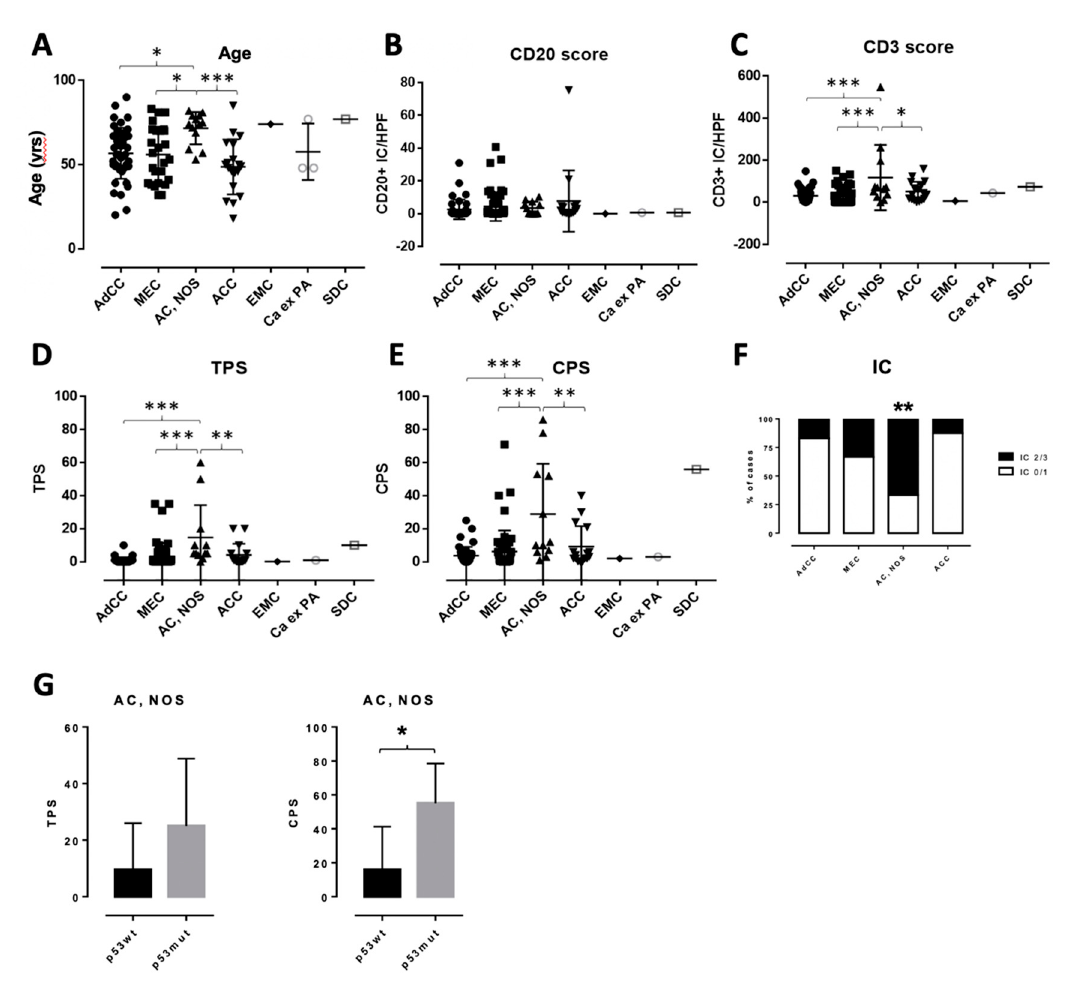
Figure 2. Graphs depicting the results for patient age ( A ), CD20 + score ( B ), CD3 + score ( C ), TPS ( D ), CPS ( E ), and IC ( F ). ( G ), TPS and CPS values in p53wt and p53mut cases of AC, NOS. * p < 0.05, ** p < 0.01, *** p < 0.001. HPF, high power